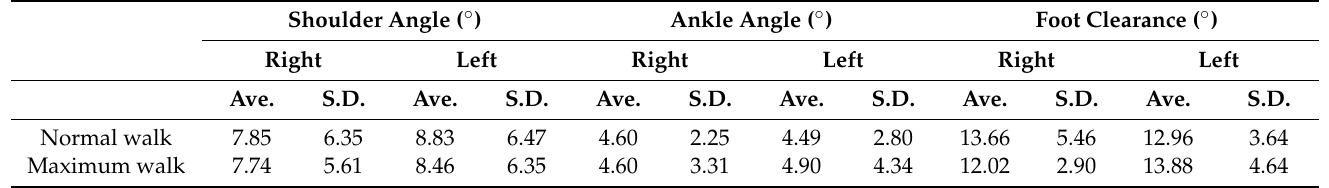
Table 9. Comparison of angle factor during the normal walking and maximum walking of ordinary